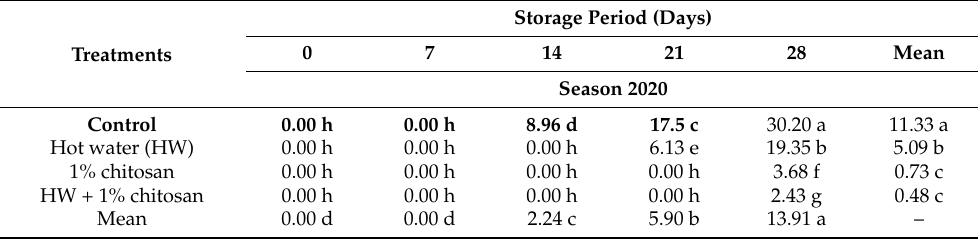
Table 1. Effect of hot water treatment and chitosan coating on postharvest decay (%) of mango fruits during storage at 13 ± 0.5 ◦ C and 85%–90% relative humidity (RH) for 28 days during 2020 season.